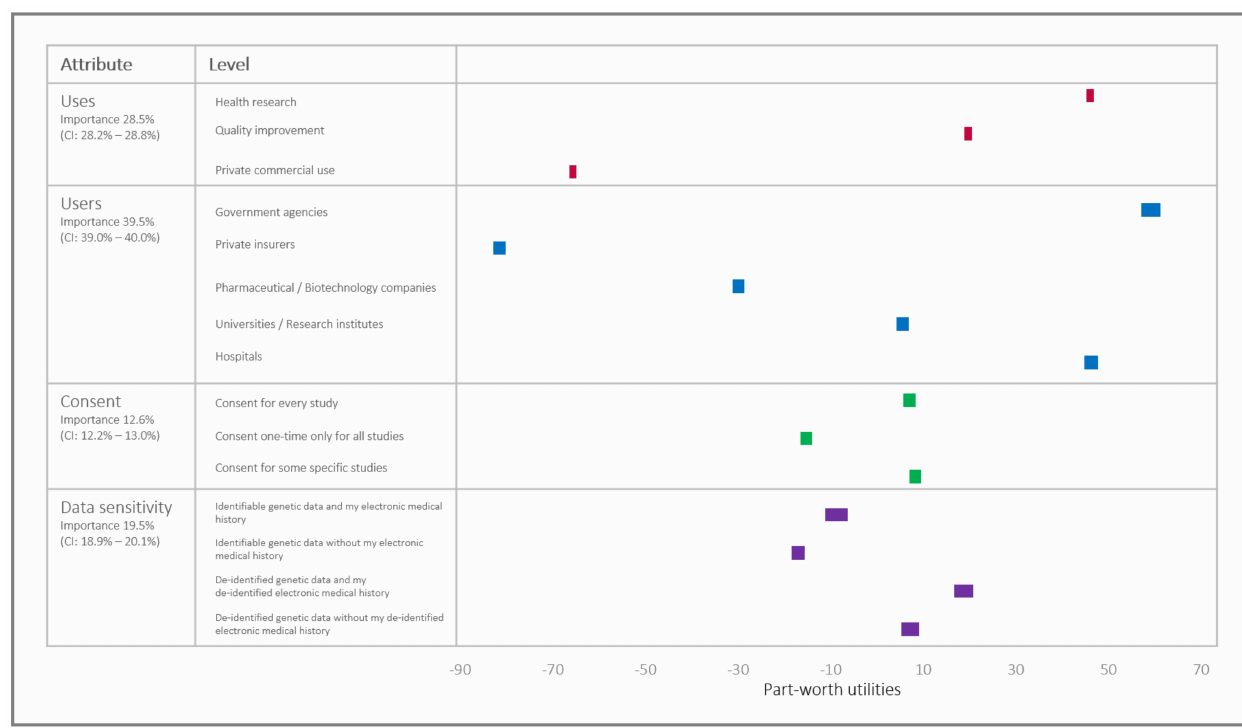
Figure 3. Part-worth utilities of the attribute levels and their importance from the ACBC analysis. A higher utility corresponds with increased willingness to share data. The width of the boxes corresponds with 95% confidence